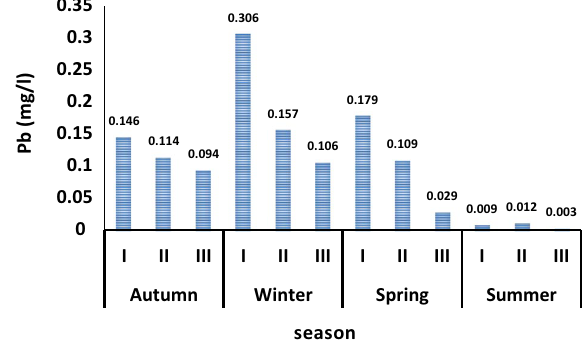
Fig. 6 Pb concentration (mg/L) in water samples from autumn 2018 to summer 2019 along the investigated